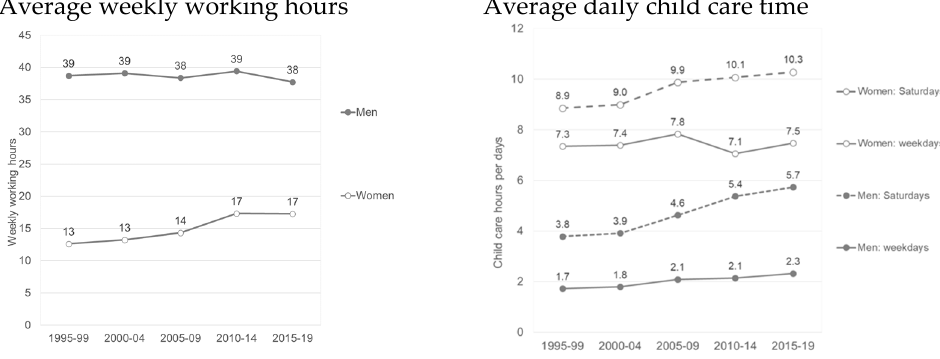
Figure 2. Average weekly working hours and average daily child care hours, women and men with children aged 12 and younger in the household, 1995–2019. Source: SOEP v36, own and weighted estimates (weighted by phrf). Note: Information for the time spent on child care on the weekends is only available every second year starting in 1995. The non-employed were included in the calculation of the mean working hours. Their working hours were set to zero.